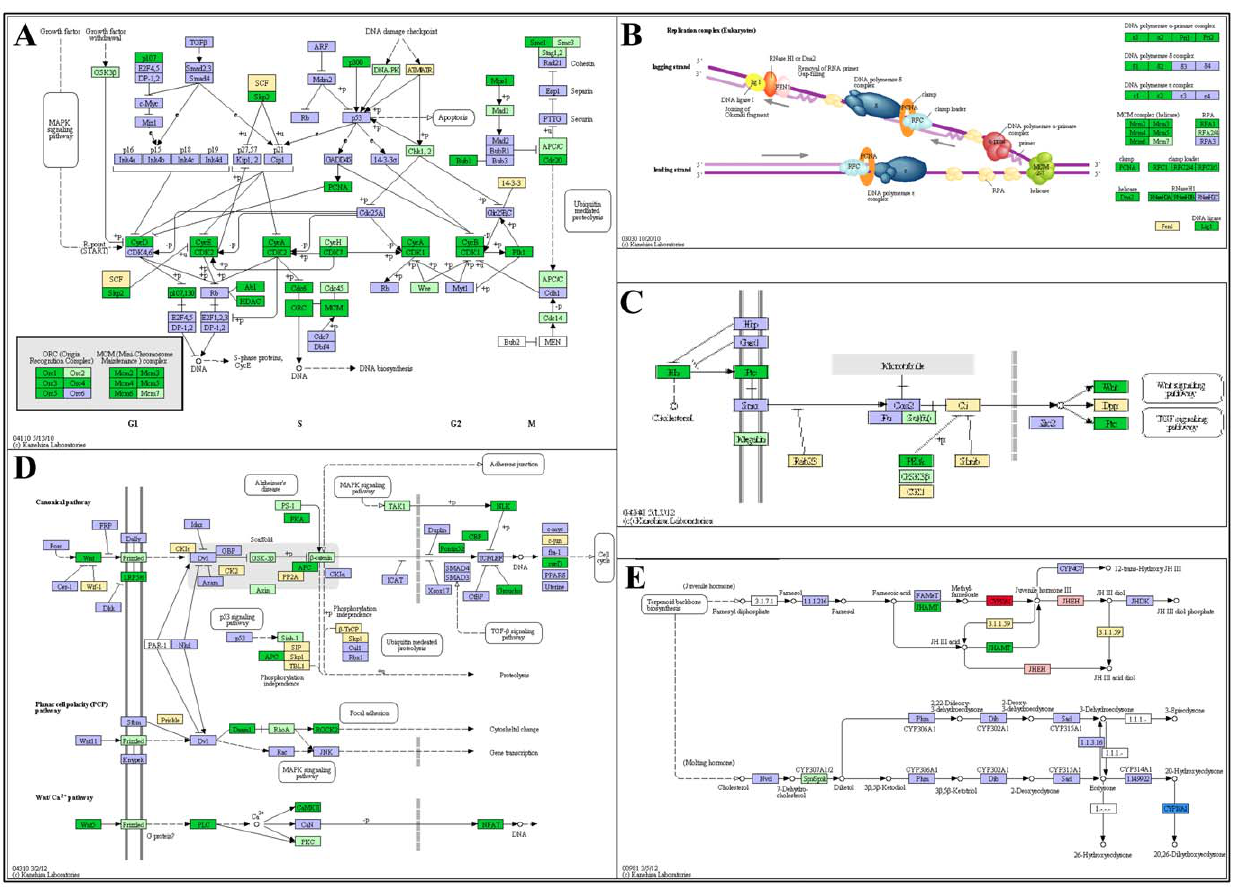
Figure 3. Representative pathways enriched in larvae or relative to metamorphosis. Cell cycle ( A ) and DNA replication ( B ) pathways, Hedgehog ( C ) and Wnt ( D ) signaling pathways all have higher representation in larvae than in PLs, while in the insect hormone synthesis pathway ( E ), the expression pattern is more ambiguous. KO terms present in KEGG pathways but absent in the M. rosenbergii developmental transcriptome are highlighted in purple. KO terms with $ 2-fold over-expression in larvae are in green, and in pale green when the ratio falls between 1.5 and 2. Yellow denotes KO terms found in our transcriptome showing no differential representation between larvae and PLs. Red denotes KO terms with $ 2-fold over-expression in PLs, changing to pink when the ratio falls between 1.5 and 2. Blue denotes ambiguous expression between larvae and PLs. Hedgehog and Wnt signaling pathways include Patched receptor (Ptc), Wnt5 and Frizzled, whose encoding transcripts were validated using real-time RT-PCR ( C and D ).